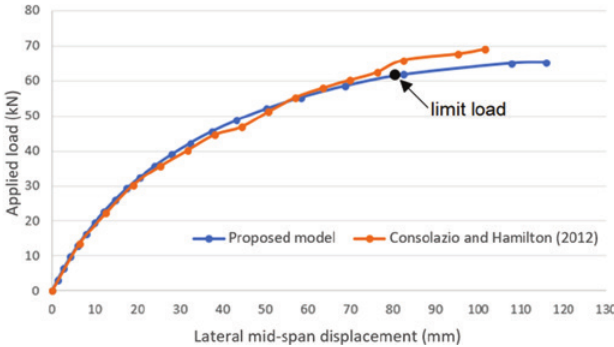
Figure 10 Loss of contact with application of self-weight and the limit load